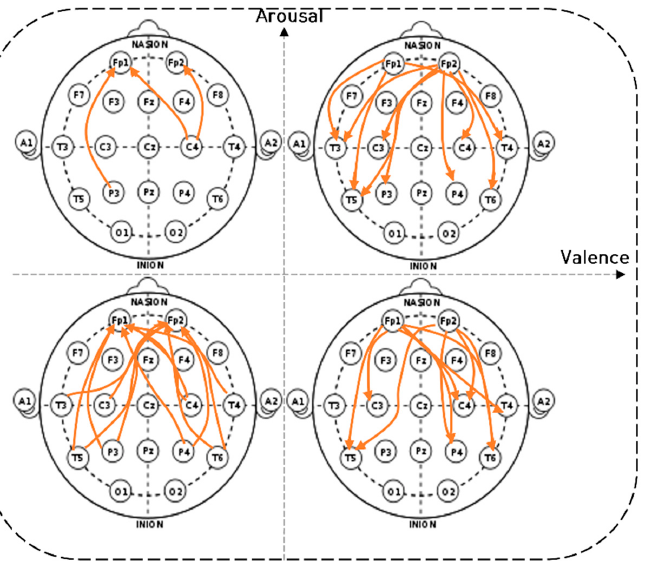
Figure 13. The long-distance connectivity of the prefrontal and temporal lobes, parietal lobes, and central (LD_pF connectivity) of the beta wave.